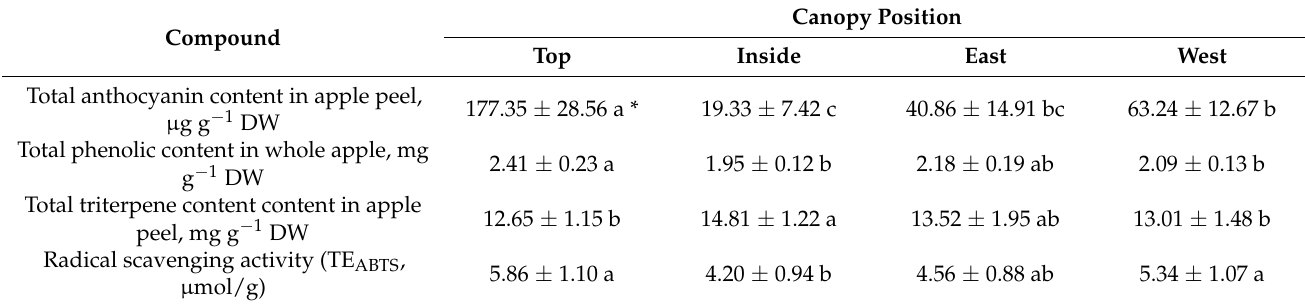
Table 6. Effect of canopy position on fruit total phenolic, triterpene and anthocyanin content and radical scavenging activity, average 2018–2020.